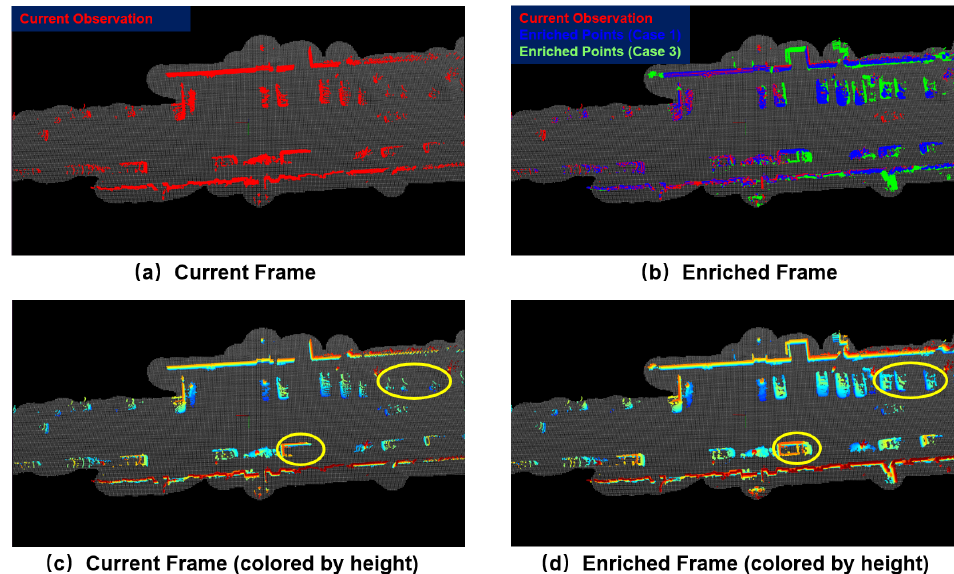
Figure 8. The current observed points, the enriched points classified as Case 1 or Case 3 are colored with red, blue, and green, respectively, in ( a , b ). For the four vehicles enclosed by the yellow ellipse, they are difficult to identify in ( c ) due to the sparse observations from a single LiDAR frame. In contrast, from the enriched frame shown in ( d ), these four vehicles are easily recognized.